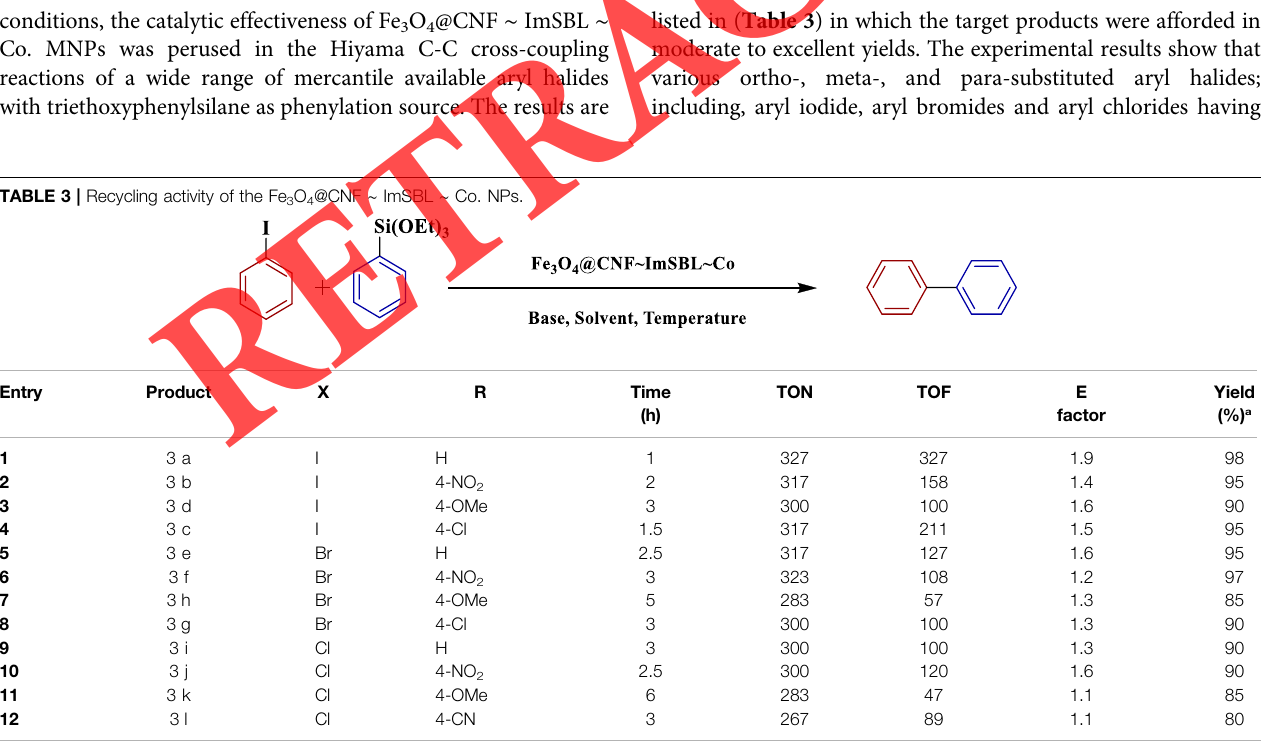
TABLE 3 | Recycling activity of the Fe 3 O 4 @CNF ∼ ImSBL ∼ Co.